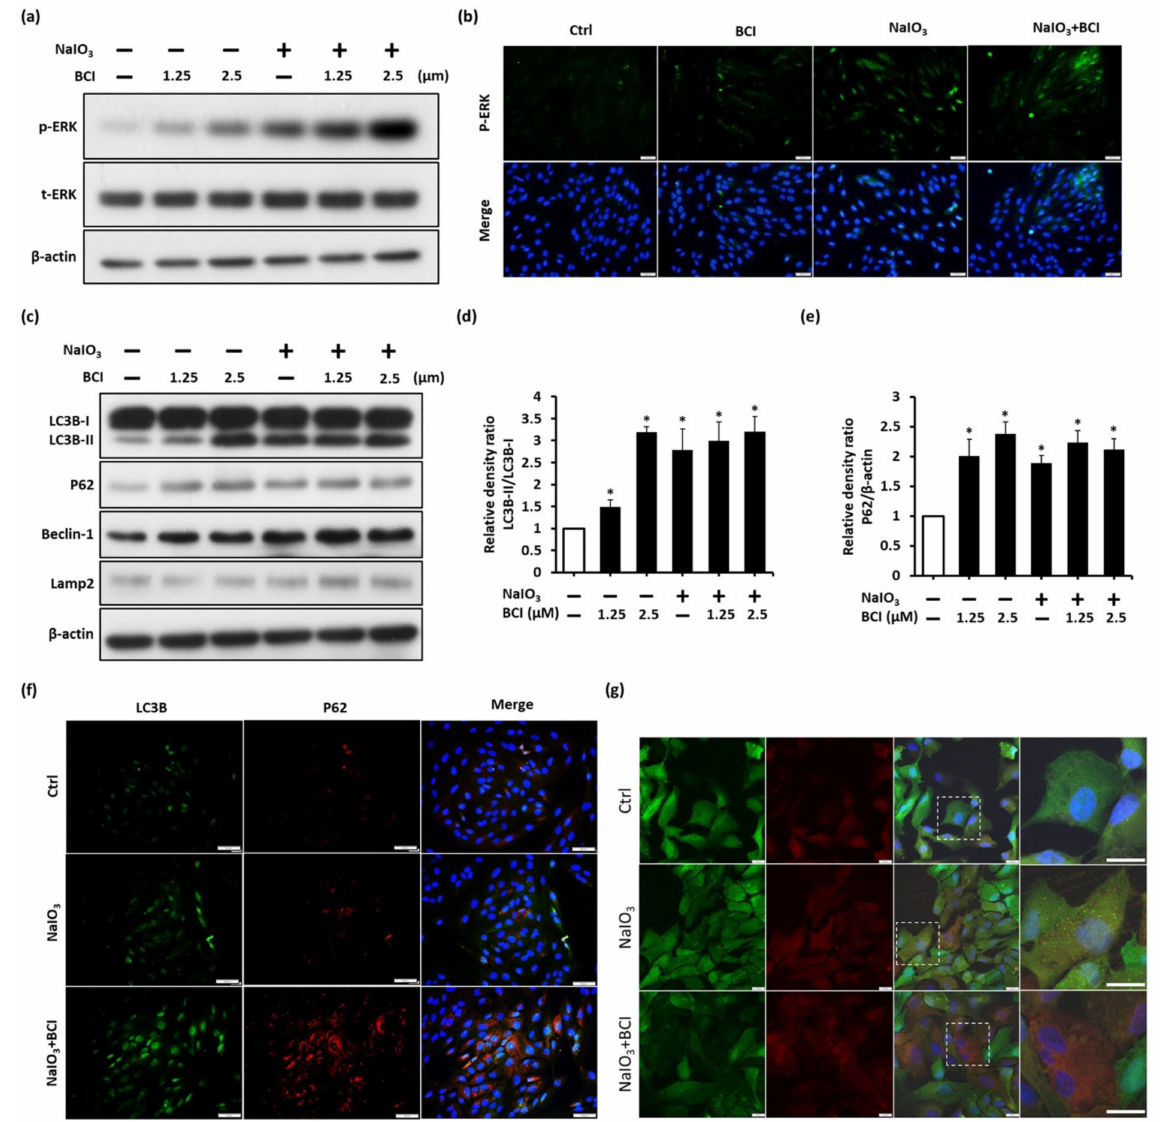
Figure 3. BCI promotes autophagic flux via ERK pathway activity in ARPE-19 cells. ( a ) Representative immunoblotting analysis of p-ERK/ERK axis expression in ARPE-19 cells treated with 1.25 and 2.5 µ M of BCI in oxidative conditions. ( b ) Immunocytochemistry staining showed the p-ERK signals in ARPE-19 cells with or without BCI treatment in oxidative conditions. Scale bar = 50 µ m. ( c ) Representative immunoblotting analysis showed the expression of autophagic relative proteins in AR-PE-19 cells treated with 1.25 and 2.5 µ M BCI in oxidative conditions. ( d , e ) Quantitative analysis of immunoblotting. Representative data from three independent experiments are shown. * p < 0.05. ( f ) Immunocytochemistry staining exhibited the LC3B and p62 expression levels in ARPE-19 cells with BCI (1.25 µ M) treatment in oxidative conditions. Scale bar = 50 µ m. ( g ) Live-image of full-length LC3B (GFP) and cleavage form LC3B (RFP) expression level. Right subpanel represents the white boxed region of the image in the left subpanel with high magnification. Scale bar = 20 µ